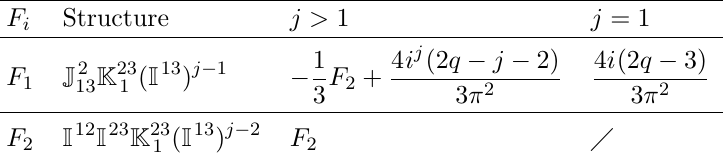
( QO ) SO when QO has h i